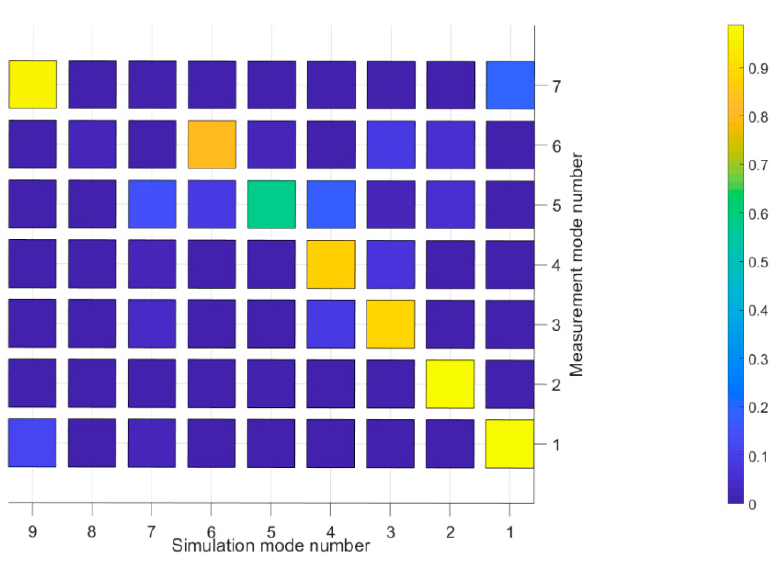
Figure 16. Measured and simulated modes.